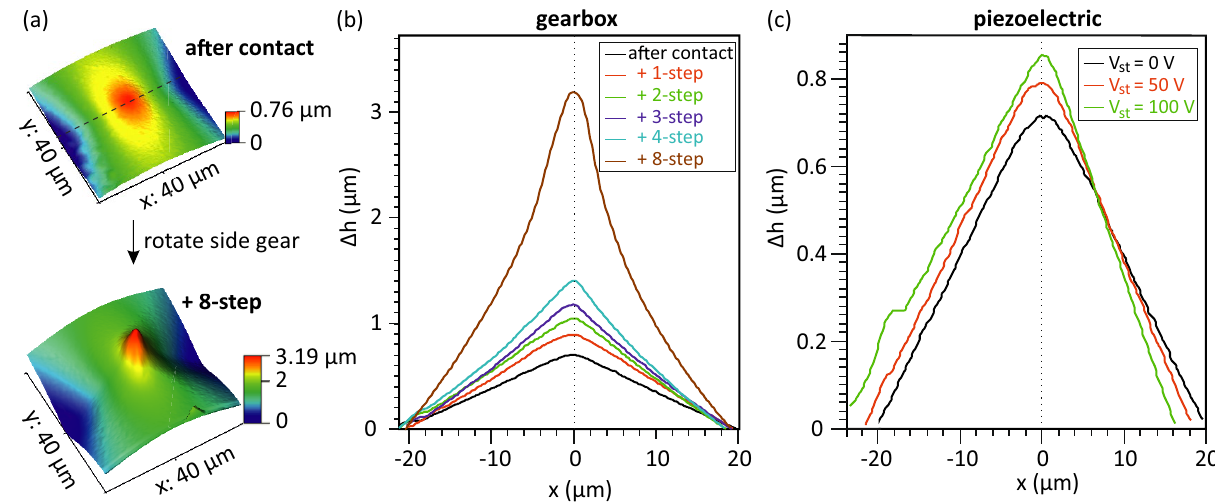
Figure 3. Height controllability of the sample and the indentor using gearbox and piezoelectric actuator ( a ) AFM topography images of polyimide surfaces taken before and after moving the polyimide film down by 8-steps using the gearbox. A step is defined as the height change when one tooth of a side gear is moved. ( b ) Height changes by gearbox control. Line profiles are taken from the center of the deformed area, shown as the black dotted line in ( a ). (cid:31) h is the height difference between the highest and lowest points in the image. The position with the maximum height is defined as the center point ( x = 0). ( c ) Height changes by piezoelectric control. The piezoelectric actuator moves around 1.8 µ m under an applied voltage (V st ) of 100 V at room